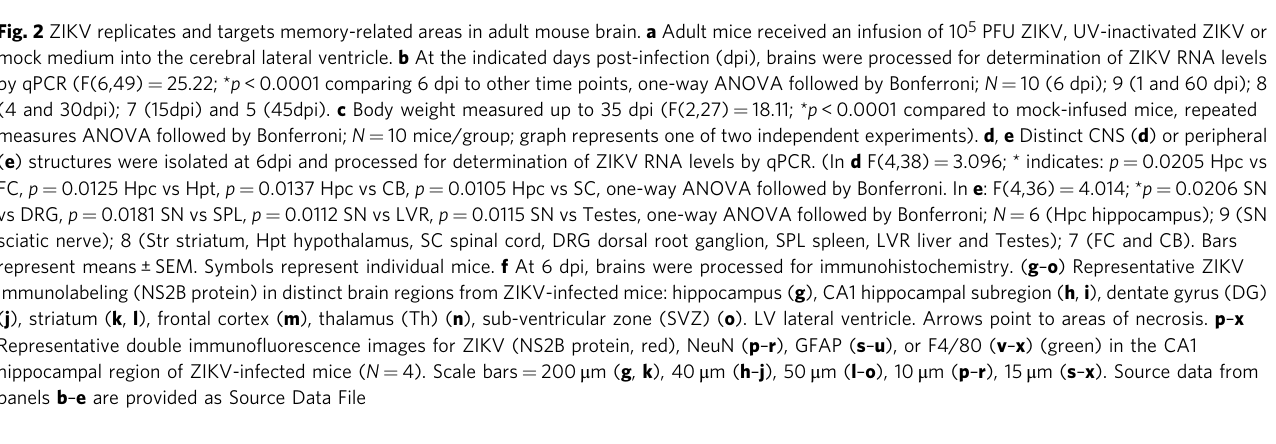
hippocampal CA3 region of ZIKV-infected mice at 60 dpi (Fig.